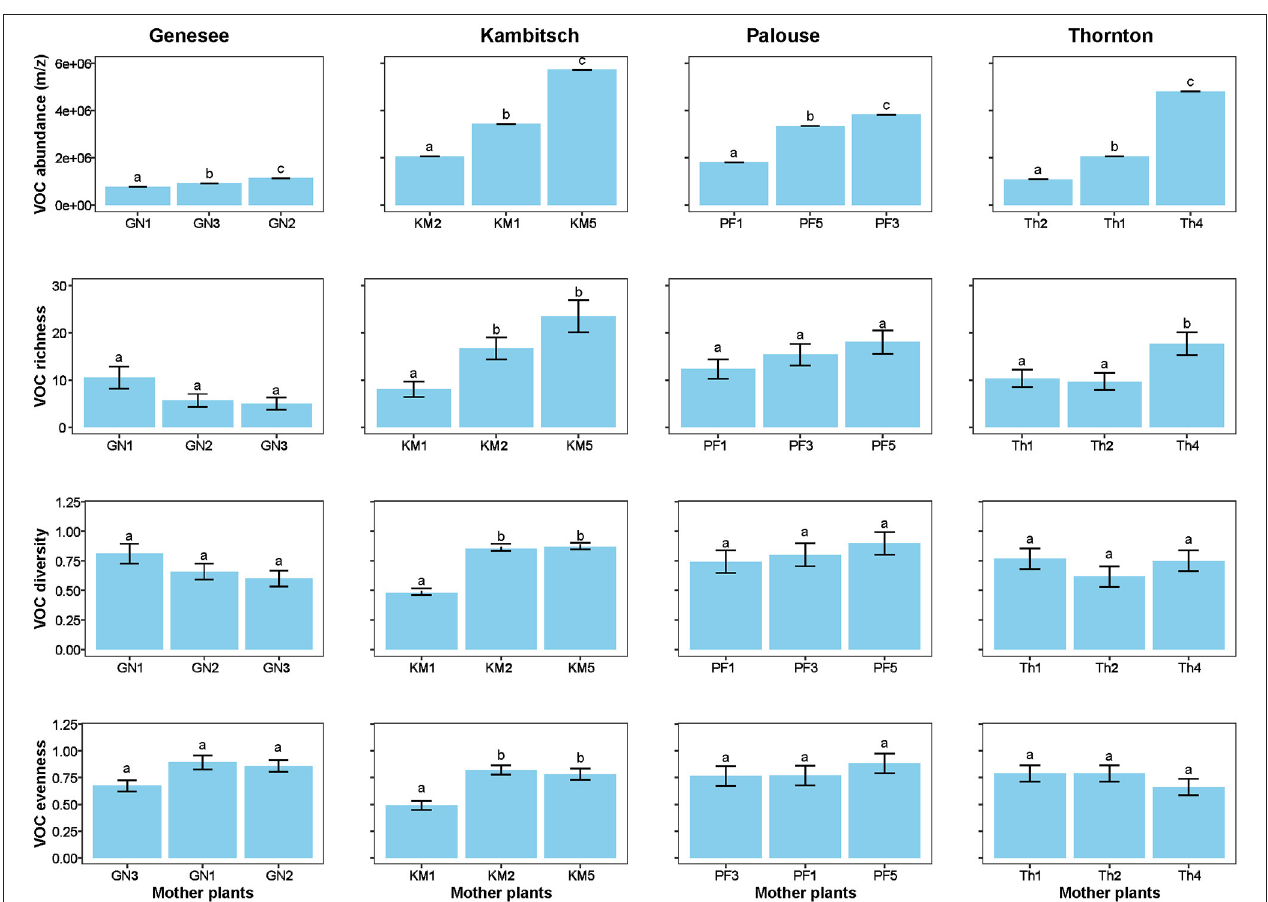
FIGURE 2 | Genetic variation of half-sib families within each population (mean ± SE) floral VOCs abundance ( m/z ), richness, diversity, and evenness across four Anthemis cotula